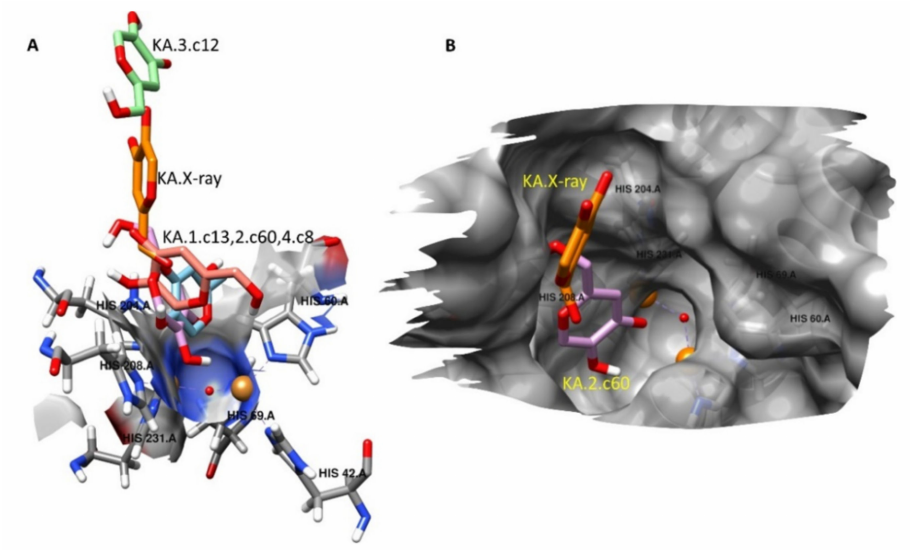
Figure 9. Representation of the catalytic site of B. megaterium tyrosinase (crystal 3NQ1): ( A ) Copper ions (orange balls), kojic acid (KA) in X-ray (orange), the best docking poses of kojic acid (magenta, blue and pink), the six histidines (turquois) coordinated to the copper ions. The red sphere represents a molecule of water. ( B ) Entrance of the catalytic site. Kojic acid in the X-ray structure (orange) and the best scoring position (violet). Copper ions (orange balls) and molecule of water (red ball)